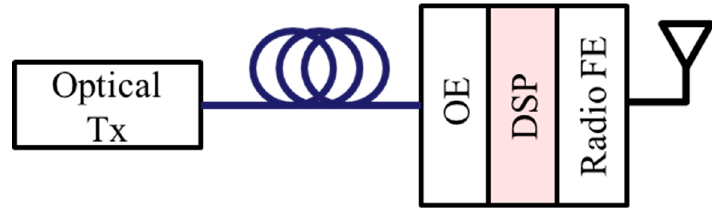
Figure 2. Configuration of conventional optical-to-radio interface for radio-wave radiation.